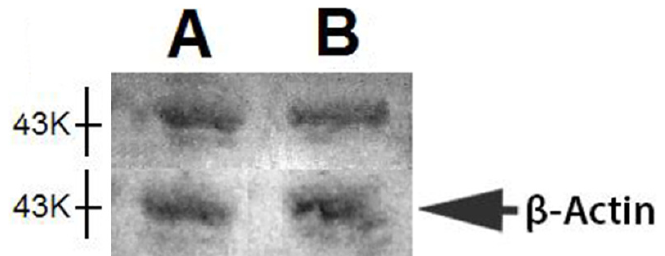
Figure 2. Representative western blot analysis of pancreatic Nkx6.1 transcription factor and β -actin of partial pancreatectomized rats treated with silymarin: ( A ) 21 days; and ( B ) 63 days after